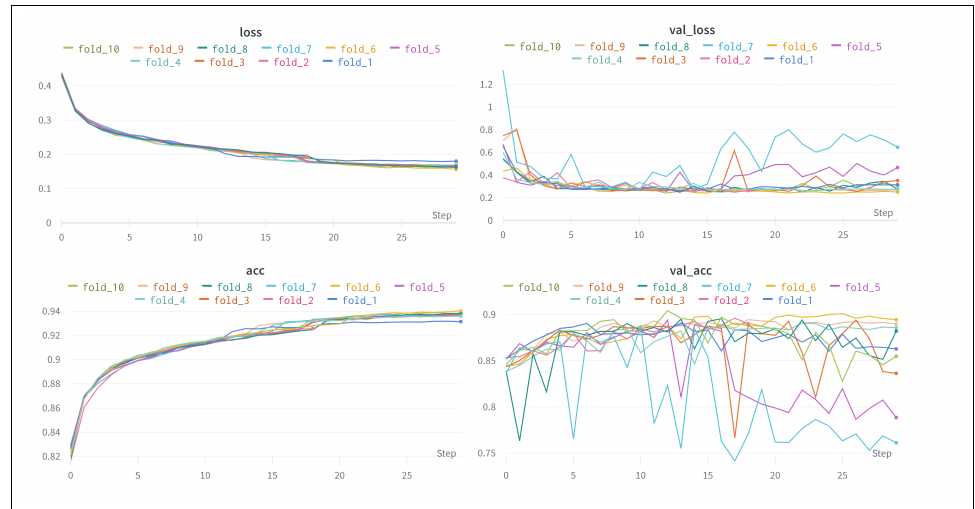
Figure 10. Training the model for the k folds. Table 3. Results of the neural network model training